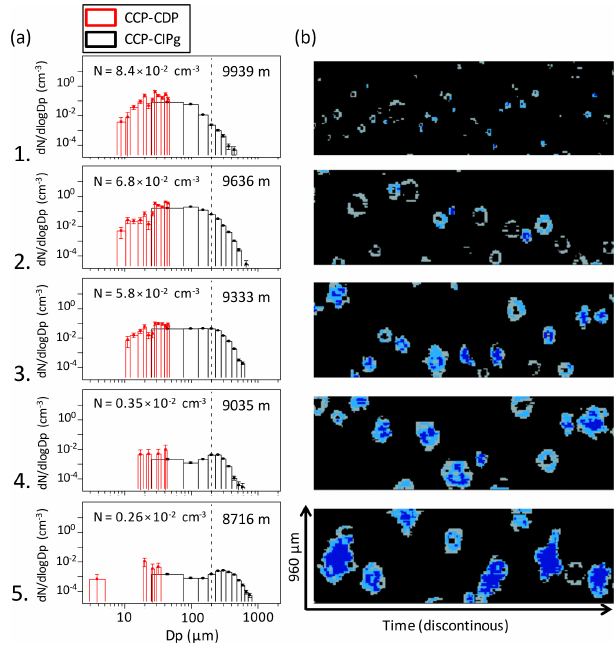
Figure 7. Microphysical characteristics of the marked flight legs from Fig. 6a. (a) Combined size distributions of the CCP-CDP (red) and the CCP-CIPg (black) instrument mounted on the AIRTOSS. With an increasing altitude, the maximum of the size distribution shifts to smaller particle diameters. (b) Sample 2-D shadow images from every single flight leg, recorded by the CCP-CIPg instrument. The different colours represent the shadow intensity (grey > 35%, light blue > 50%, dark blue >